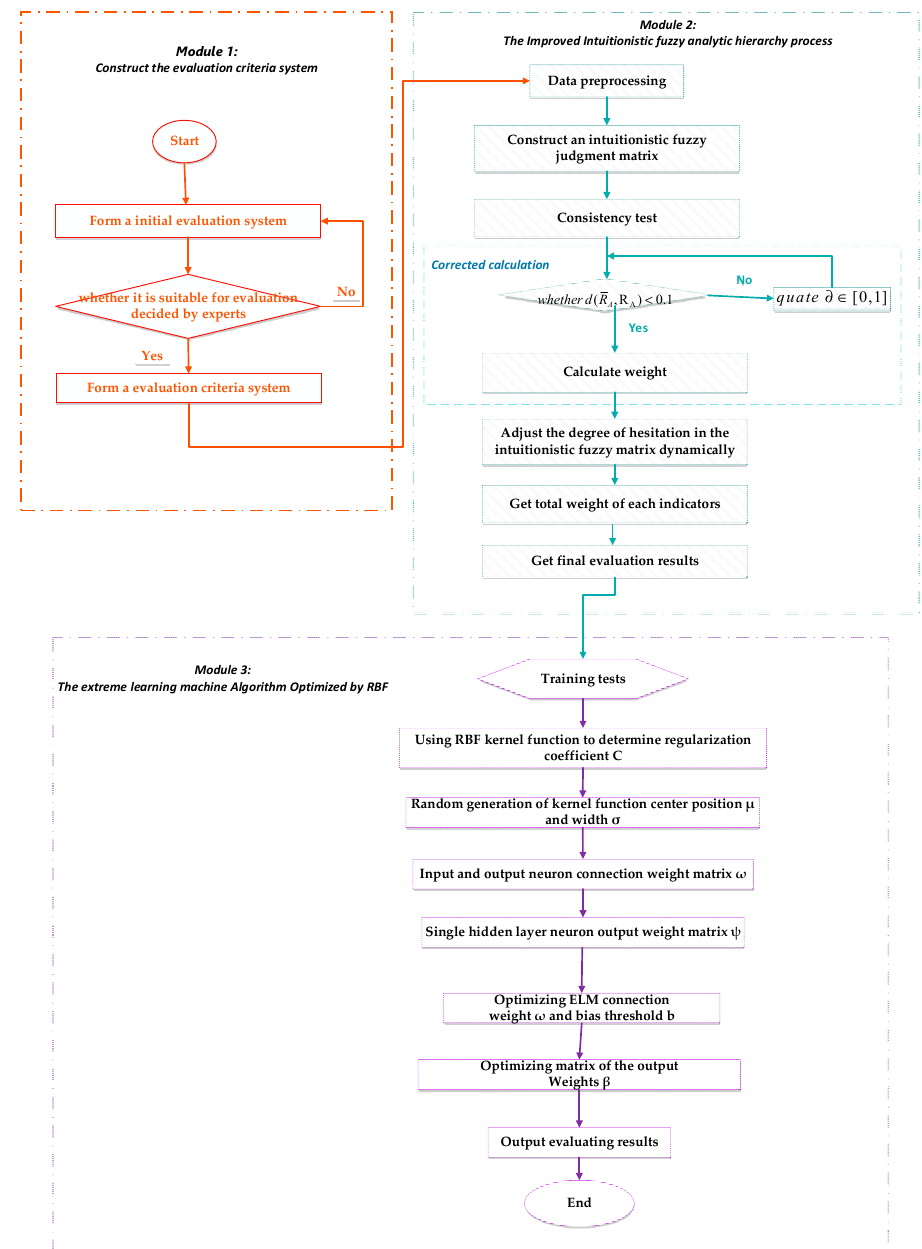
Figure 3. Flow chart of comprehensive evaluation of low-carbon sustainability and green operation benefits to power generation enterprises .